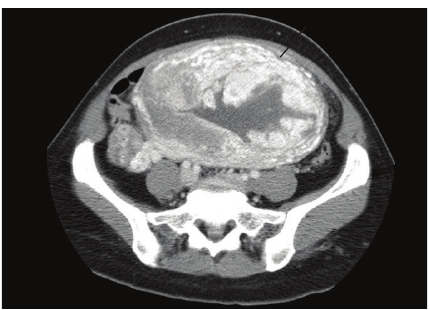
Figure 3: Contrast-enhanced CT image demonstrates hypervascu- lar uterine mass. Note loss of plane between the mass and the uterine wall (white arrow).